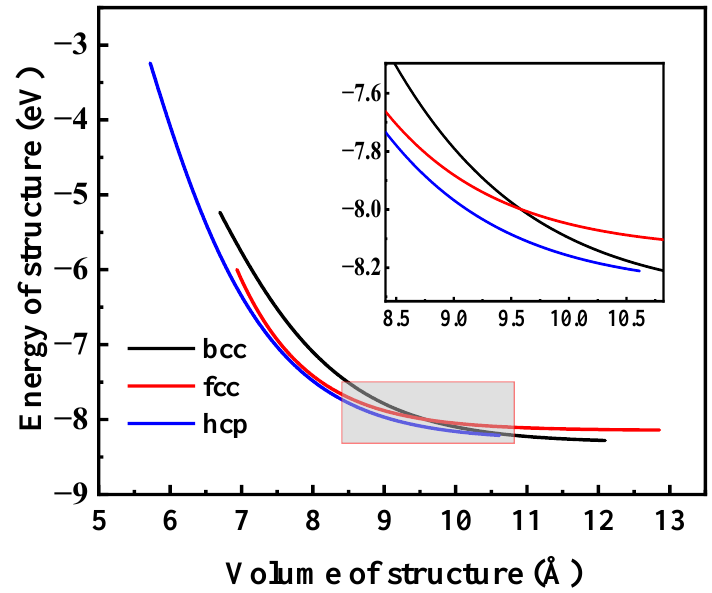
Figure 5. Energy vs. volume relations for bcc, hcp, and fcc Fe.